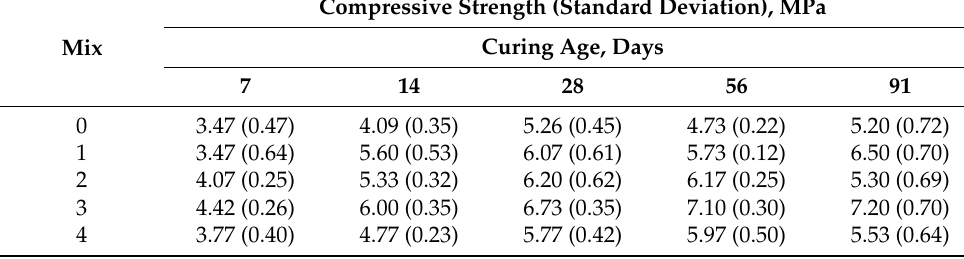
Table 9. Average compressive strength for the different considered pozzolanic-concrete mixtures at different curing